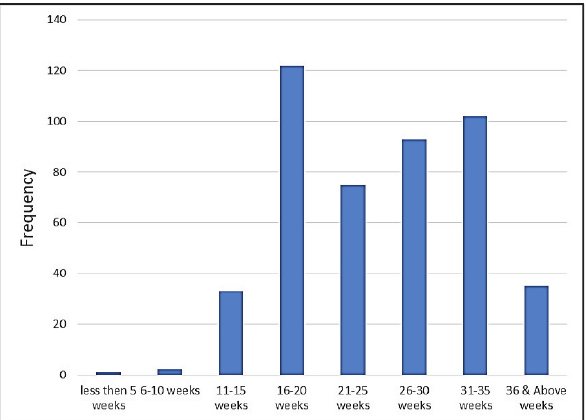
Fig-1: Gestational Age Groups of Study Participants(weeks)